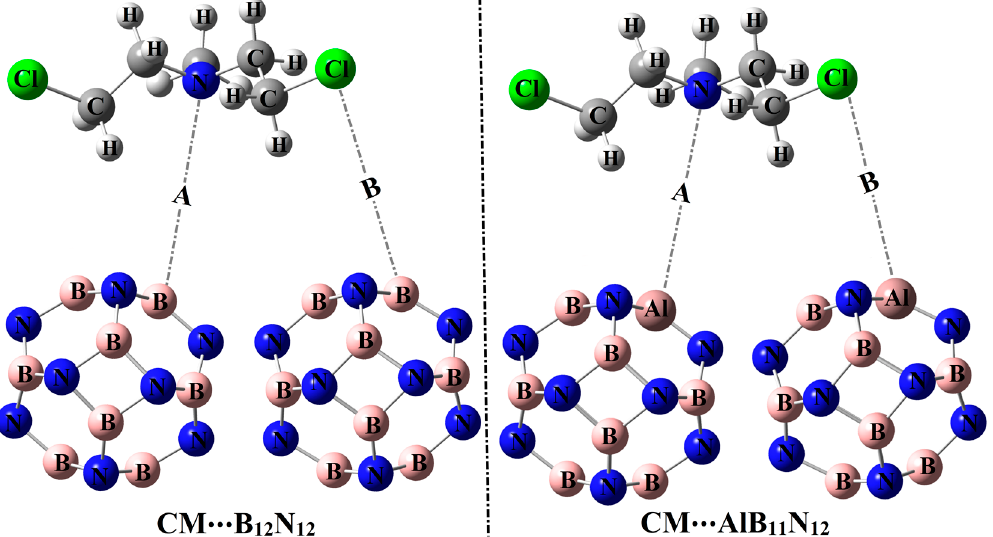
Figure 1. Pictorial representation for the adsorption process of the Chlormethine (CM) anti-cancer drug over pure and aluminum (Al)-doped boron nitride (B 12 N 12 and AlB 11 N 12 ) nanocarriers through configurations A and B.